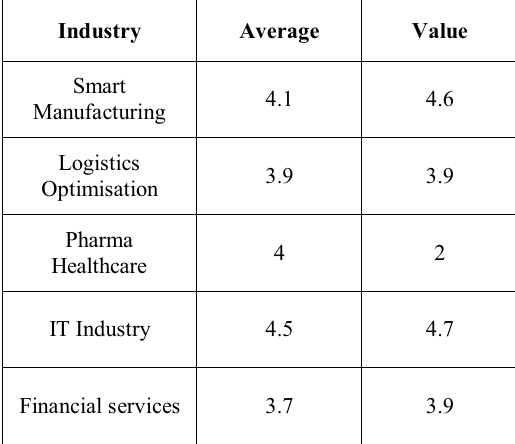
Table 1. Impact of AIoT on different industries [17] Industry